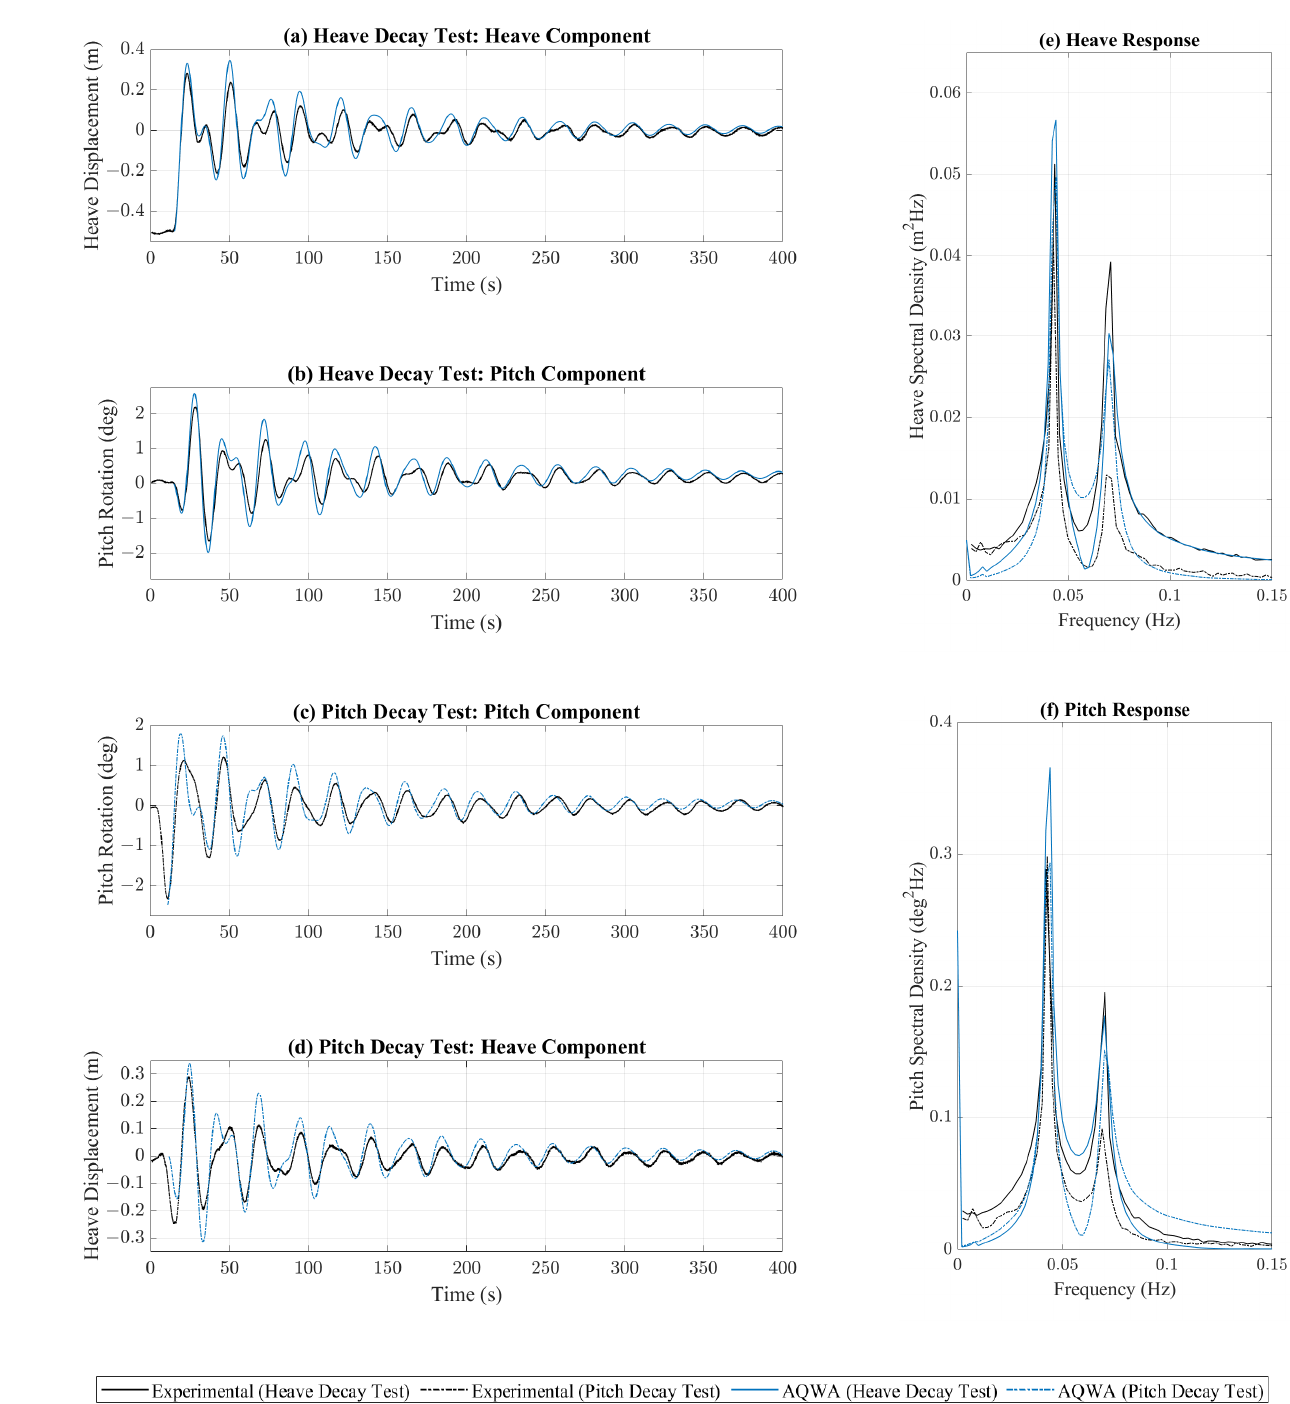
Figure 6. ( a ) Heave displacement during heave decay test, ( b ) pitch rotation during heave decay test, ( c ) pitch rotation during pitch decay test, ( d ) heave displacement during pitch decay test, ( e ) heave spectral response, and ( f ) pitch spectral response.